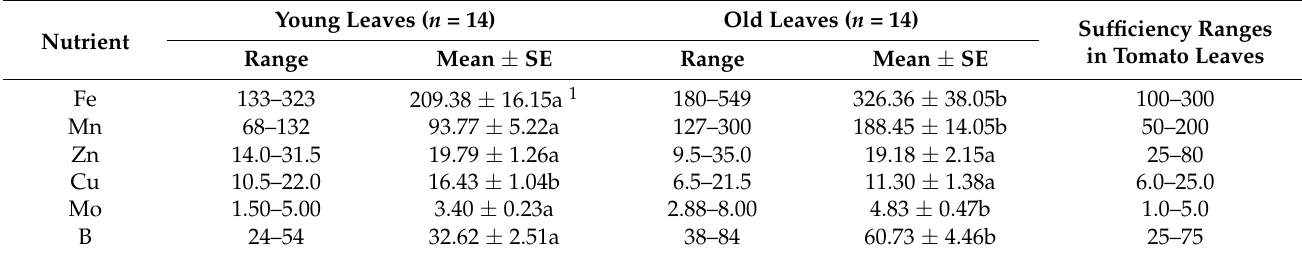
Table 2. Micronutrient concentration (mg kg − 1 , dry matter) in young and older ‘Beorange’ tomato leaves during the crop cycle from September 2020 to April 2021. Nutrient sufficiency ranges for the youngest fully developed tomato leaves were indicated according to the established reference values [26–28].